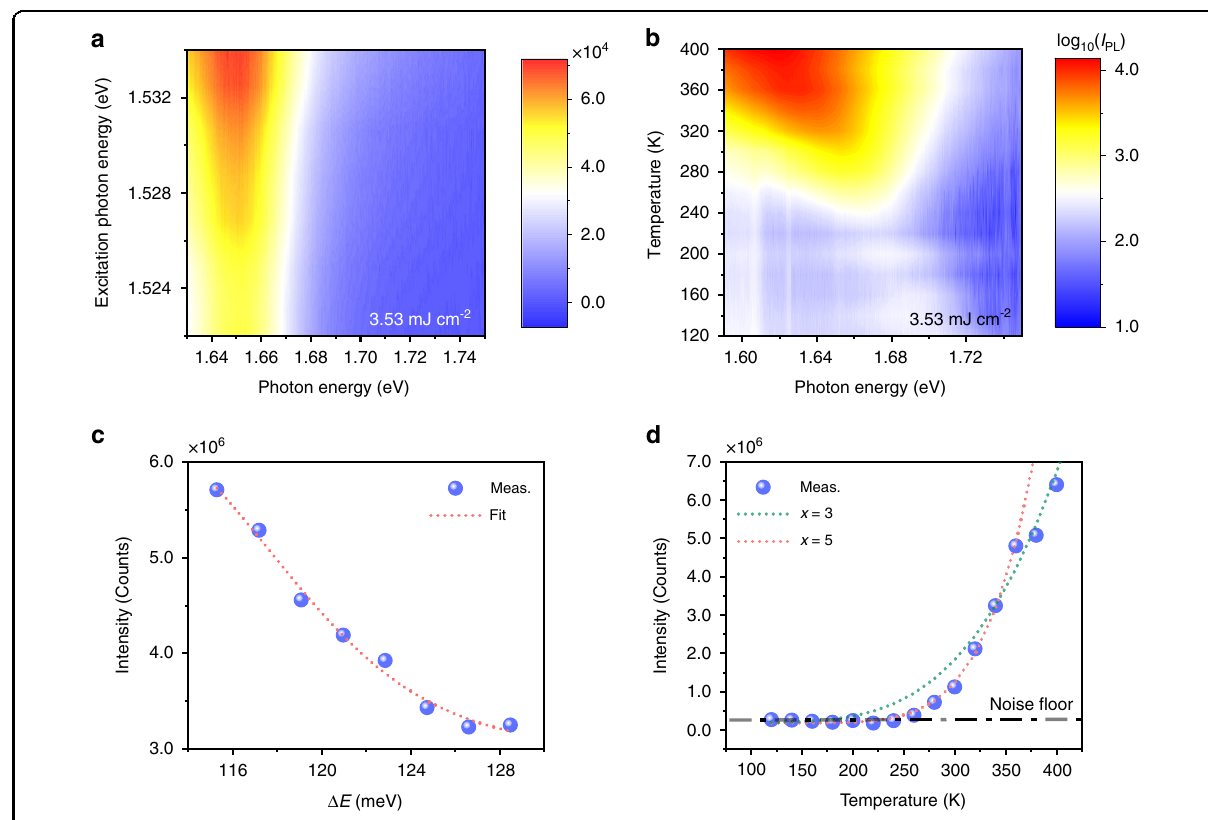
Fig. 2 Phonon-assisted excitonic upconverted emission of monolayer WSe 2 . a Excitation photon energy-dependent upconverted emission spectra. b Excitation photon energy-dependent integrated upconverted emission intensity extracted from ( a ). The red dotted line represents the fi tted result based on the Boltzmann function. c Temperature-dependent upconverted emission spectra for excitation photon energy at 1.52 eV. d Temperature-dependent integrated upconverted emission intensity extracted from ( c ). The upconverted emission intensity is proportional to n x , (cid:1) (cid:3) (cid:4) (cid:5) (cid:2) 1 is the average population of phonon gas in monolayer WSe 2 and x is the involved phonon number in single where n ¼ 1 = exp (cid:1) h ω q = k B T unconverted emission. The green and red dotted lines show the fi tted results for x = 3 and 5,